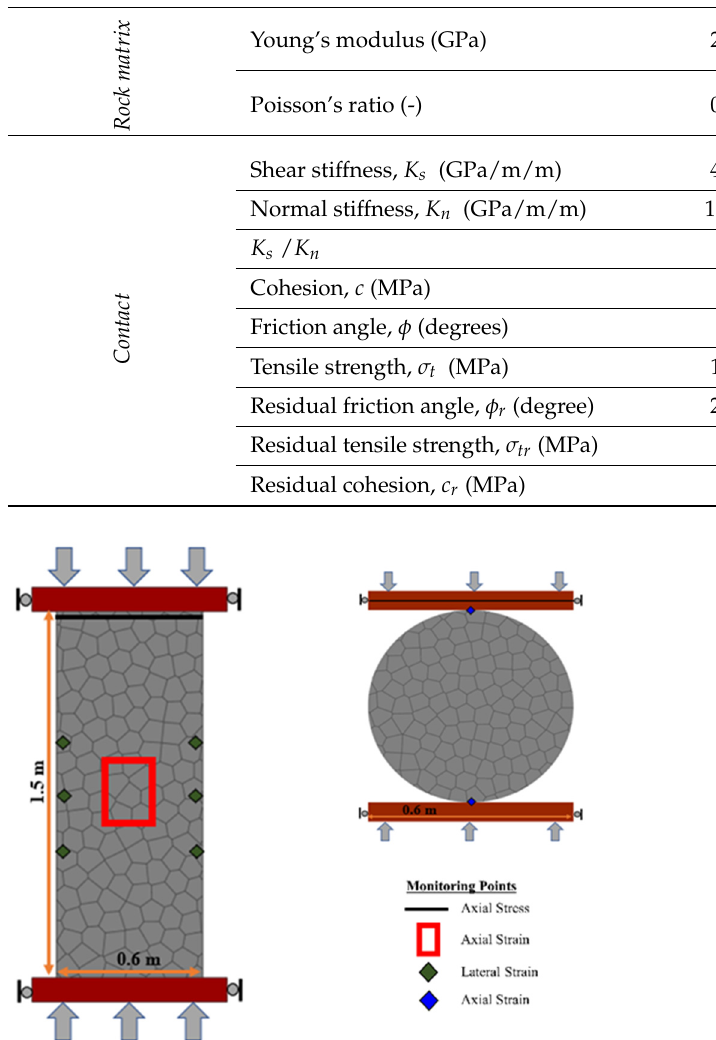
Table 2. Calculated mechanical properties for the laboratory and in situ strength of the coal and sandstone rocks.